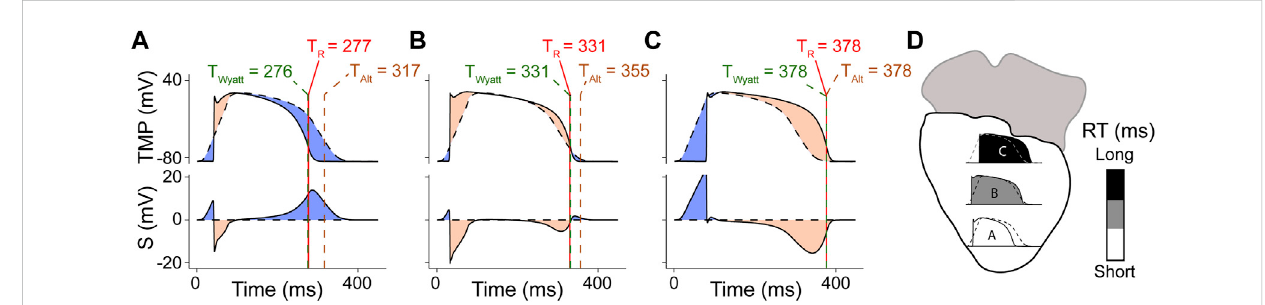
FIGURE 7 Model for improved interpretation of the UEG, as proposed by Potse et al. (Potse et al., 2009), and slightly adapted from the original version. Panels (A – C) denote different locations (highlighted in panel (D) ). The top frame of each panel shows simulated TMPs from 3 different locations in the model (solid line) and the location-independent mean action potential (dashed). The second frame shows S, i.e., the UEG itself (computed with the model), which is the subtraction of both. Each red vertical line indicates TR, i.e., the instant of minimum dVdt in the TMP. Each of these lines is half obscured by adashed green line,whichindicates tWyatt, leading to a green-red dashed line. Each dashed brown vertical line indicates tAlt. (A) Action potential and UEG for a short-RT-region, resulting in a positive UEG T-wave. (B) intermediate-RT-region, resulting in a biphasic T-wave. (C) long-RT-region, resulting in a negative